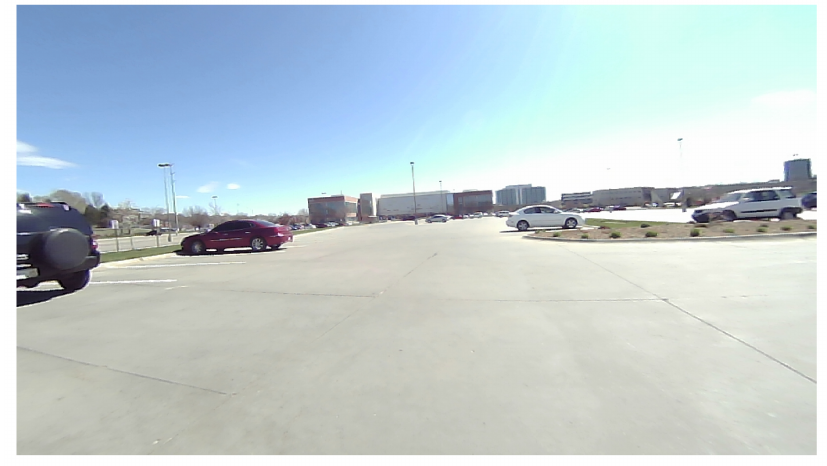
Figure 5. Rectilinear image.